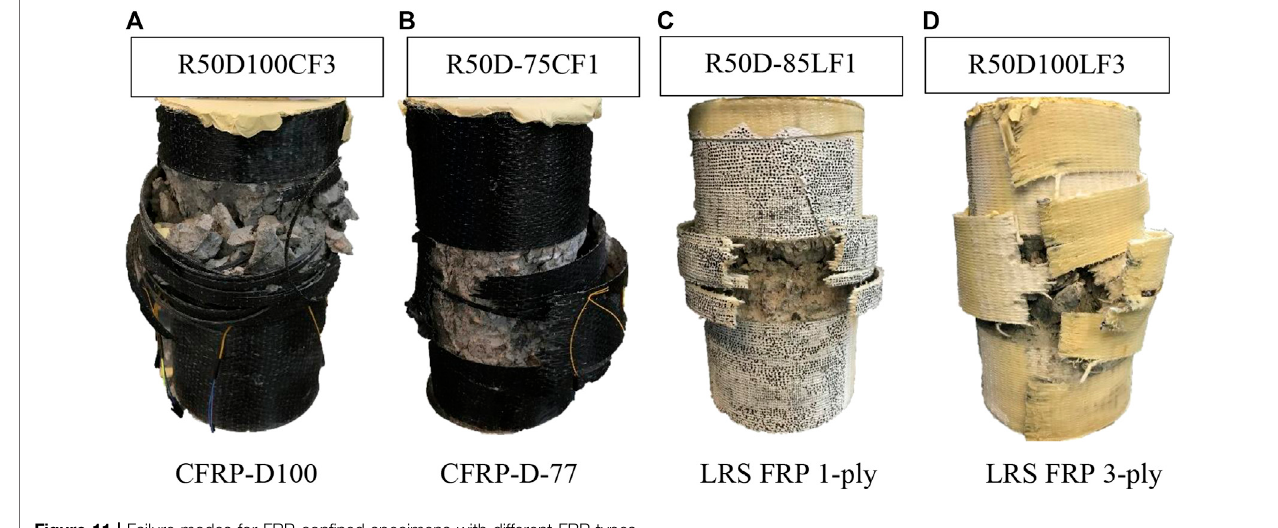
Figure 11 | Failure modes for FRP-con fi ned specimens with different FRP types.